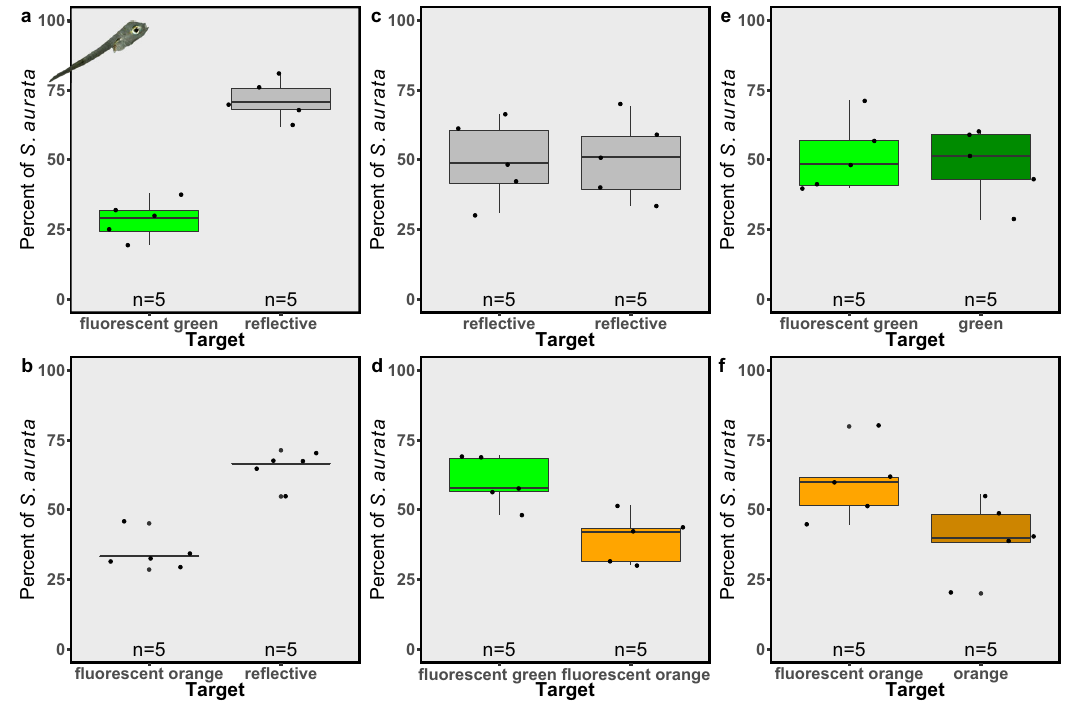
Fig. 3 The attraction of Sparus aurata larvae to fl uorescent and non- fl uorescent targets. Attraction to fl uorescent ( fl uorescent green or fl uorescent orange) or non- fl uorescent (re fl ective, green, and orange) targets presented as the percentage of S. aurata attracted to each target. a Re fl ective target (gray boxes) versus fl uorescent green target (bright green boxes), b re fl ective target versus fl uorescent orange target (bright orange boxes), c re fl ective target versus re fl ective target, d fl uorescent green target versus fl uorescent orange target, e fl uorescent green target versus a non- fl uorescent green target (dark green boxes), and f fl uorescent orange target versus non- fl uorescent orange target (dark orange boxes). n = 5 trials for each combination. Boxes represent the upper and lower quartile, centerlines represent medians, and whiskers extend to data measurements that are less than 1.5*IQR away from the fi rst/third quartile.